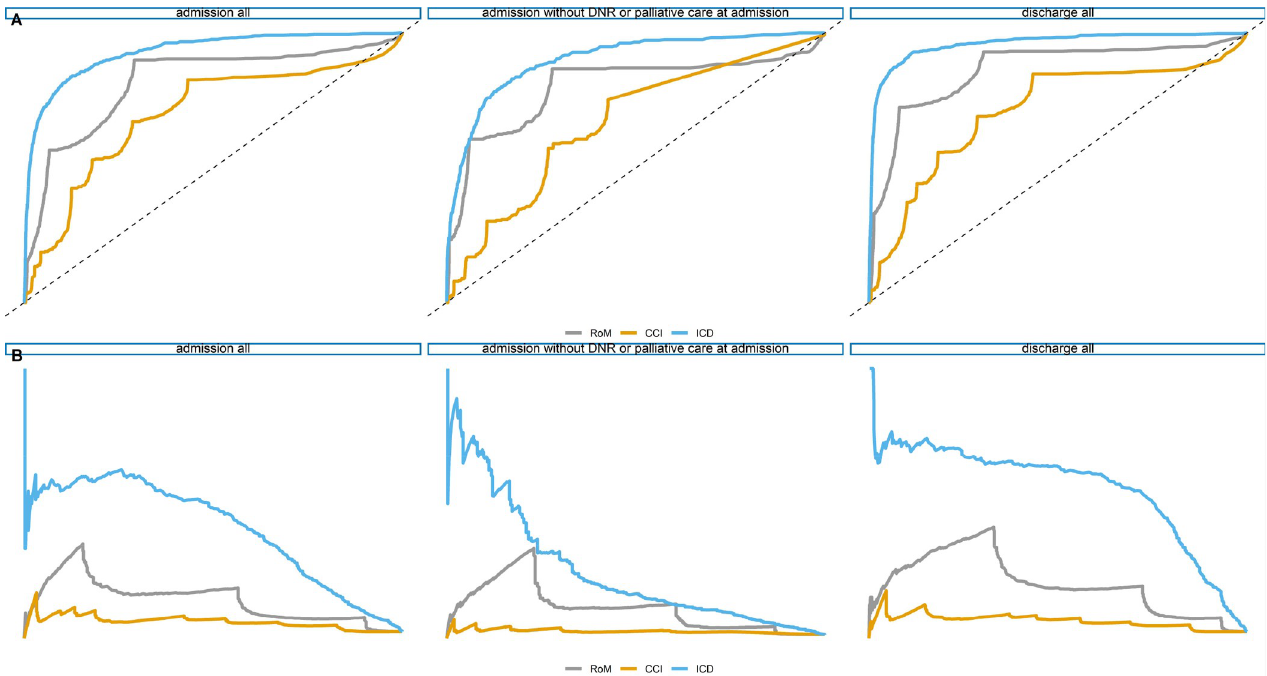
Fig 2. A (Upper panel). ROC curves showing the results using three different sets of predictors in the Random Forests model. The figure on the left shows the ROC curve with all diagnoses known at admission, while the figure on the right shows all diagnoses known at discharge. The ROC curve in the middle is for the models using only the diagnoses known at admission, excluding all admissions with DNR and palliative care codes at admission. B (Lower panel). Precision- Recall plot showing the results using three different sets of predictors in the Random Forests model. The figure on the left shows the PR curve with all diagnoses known at admission and on the right all diagnoses known at discharge. The PR curve in the middle are the models using only the diagnoses known at admission, excluding all admissions with codes DNR or palliative care codes at admission. Both approaches show low performance using CCI as a predictor for in-hospital mortality, while the models using ICD as predictors perform best overall. Legend: CCI = Charlson Comorbidity Index; RoM = Risk of Mortality; ICD = International Classification of Diseases.